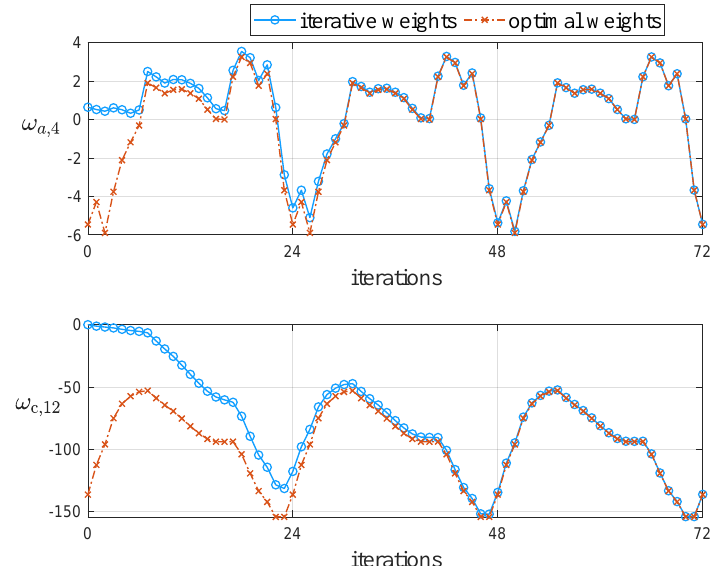
Figure 5. The iterative weights of the QOADP under periodic